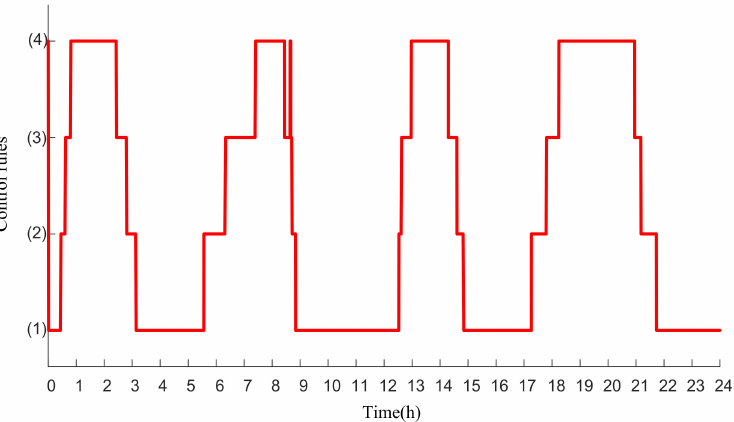
Figure 17. Operational state of rules over 24